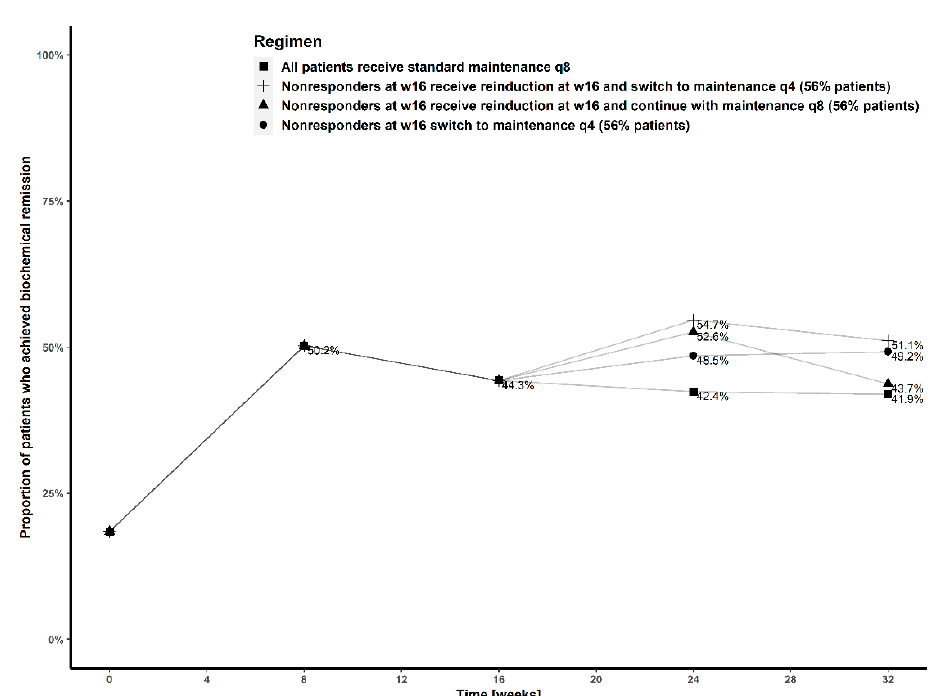
Figure 4. Proportion of patients who achieved biochemical remission at weeks 8, 16, 24 and 32, with standard treatment ( ■ ), treatment where patients not in remission at week 16 received maintenance dosing every four weeks from week 20 ( ● ), treatment where patients not in remission at week 16 received intravenous reinduction at week 16 and continued with maintenance dosing every eight weeks ( ▲ ), and treatment where patients not in remission at week 16 received intravenous reinduction at week 16, followed by maintenance dosing every four weeks from week 20 (+).